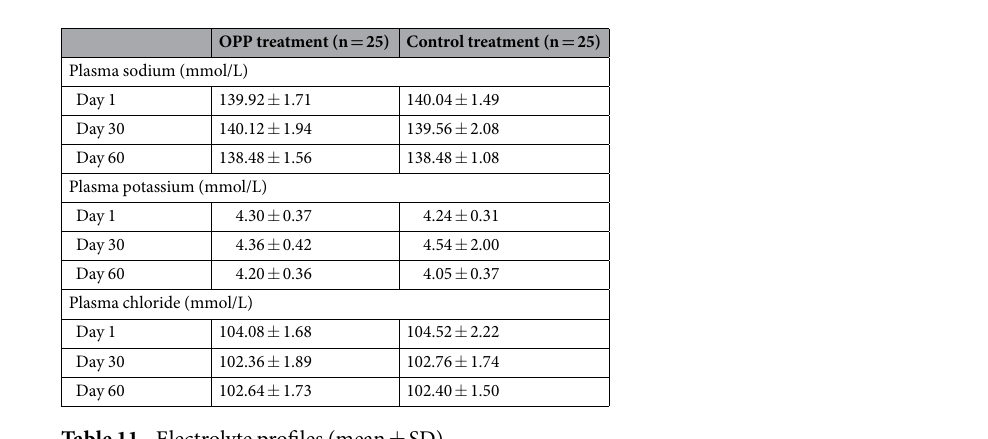
Table 11. Electrolyte profiles (mean ±